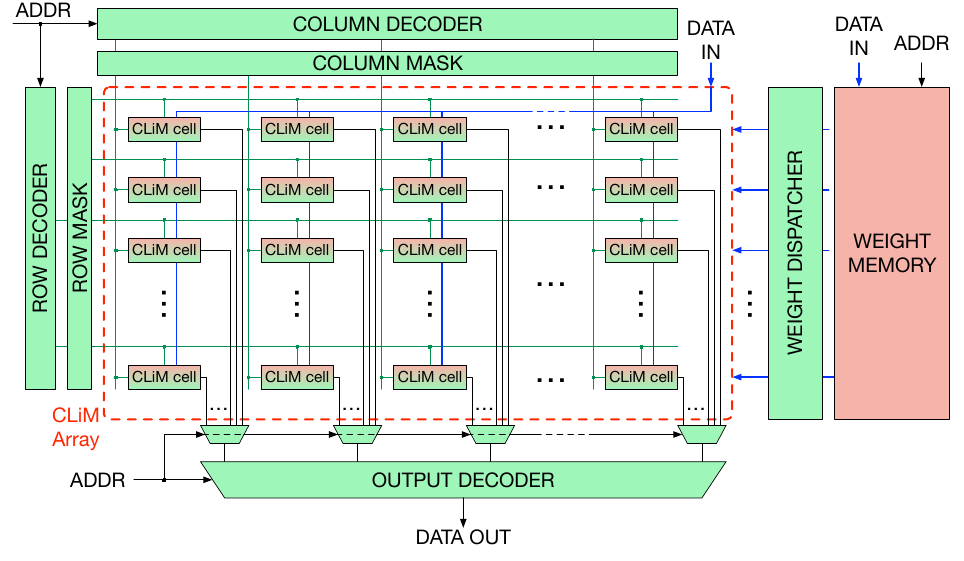
Figure 10. Architecture of CLiMA for quantized